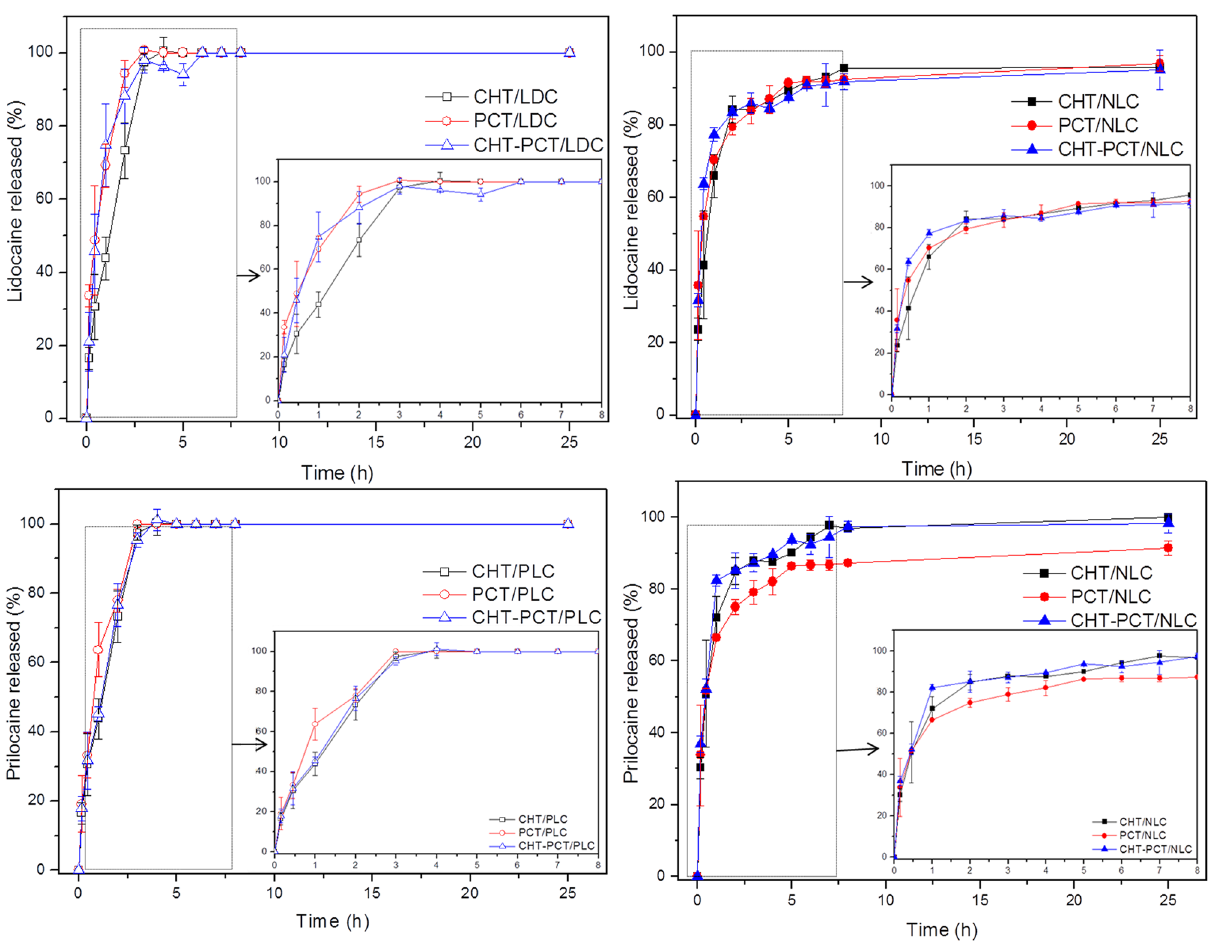
Figure 2. In vitro sustained release profile of lidocaine (top) and prilocaine (bottom) from biopolymers (left) and hybrid nanofilms (right). Data mean ± S.D., n = 6, 37 °C. LDC 2.5% lidocaine, PLC 2.5% prilocaine, CHT 2% chitosan, PCT 2% pectin, CHT–PCT 2% chitosan-pectin, NLC nanostructured lipid carriers encapsulating 5% LDC–PLC.